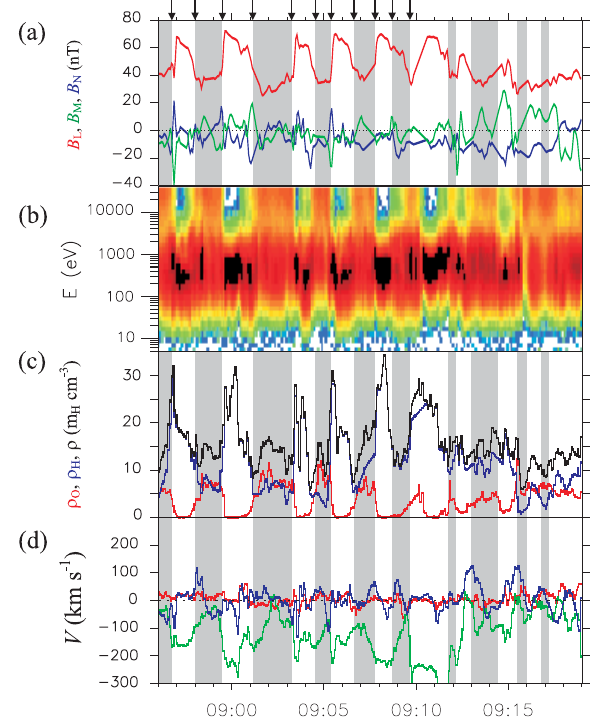
Fig. 12. Closer look at the measurements on 30 December 2001 from 8:56:00 to 9:19:00 UT. ( a ) Magnetic field compo- nents in the LMN frame; ( b ) ion energy-time spectrogram in Log[eV/(scm 2 sreV)] from HIA; ( c ) O + (red), H + (blue), and total (black) mass density of in cm − 3 from HIA; and ( d ) single-fluid ve- locities in the LMN frame in kms − 1 . L, M, and N components are plotted in red, green and blue, respectively.